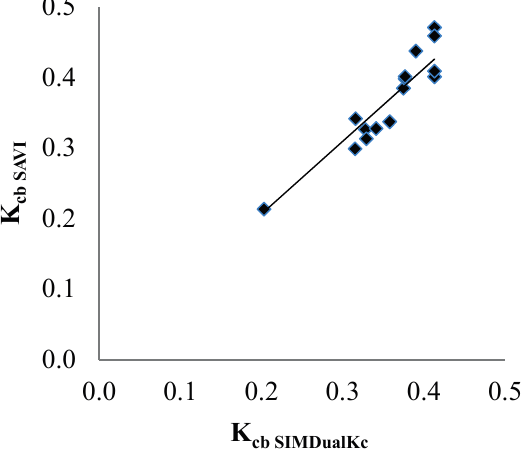
Figure 5. Comparison of actual K cb obtained with SIMDualKc (K cb SIMDualKc ) with K cb derived from SAVI (K cb SAVI ) for olive when f c is estimated from